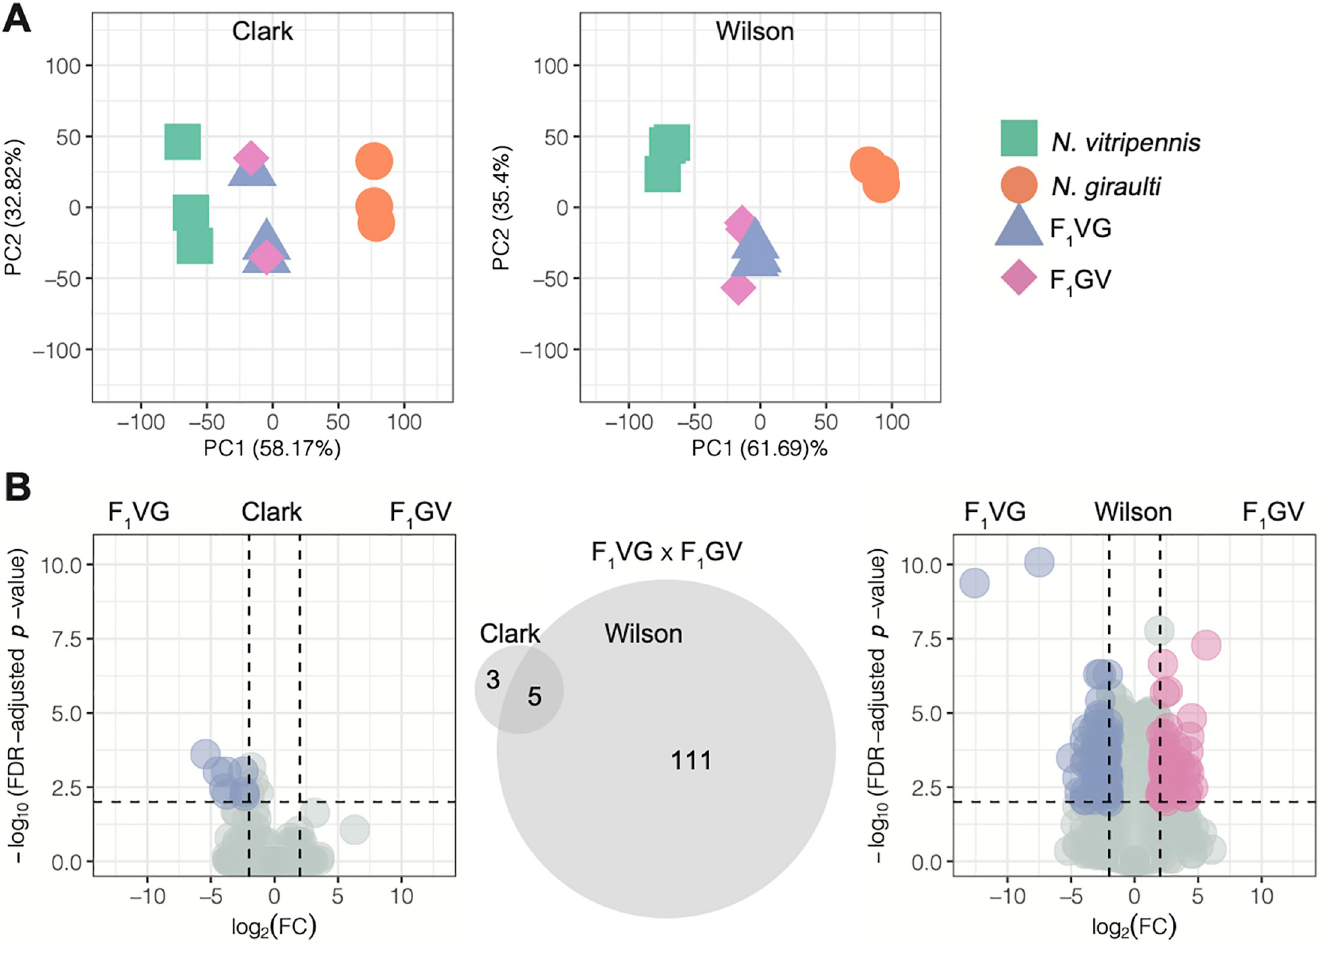
strain of N . giraulti , R16A, that has a nuclear genome derived from N . giraulti but maintains N . vitripennis mitochondria, therefore the R16A Clark hybrids all have the same genetic makeup whereas the Wilson reciprocal hybrids have the same nuclear genome but different cytoplasms; yet, we do see eight genes called as differentially expressed between the VG and GV hybrids in the R16A Clark data. Three of the eight genes in the R16A Clark data (LOC116416025, LOC116416106, LOC116417553) were only called as differentially expressed between the VG and GV hybrids in the R16A Clark dataset and weren’t called as differentially expressed in the Wilson dataset. The other five genes (LOC107981401, LOC100114950, LOC116415892, LOC103317241, LOC107981942) were called as differentially expressed between the VG and GV in both datasets. In the Wilson data, we called 116 DEGs, 111 of which are unique to the Wilson data set. The original Wang et al. 2016 publication did not investigate differential expression between the hybrids [20]. Here we report a new way of look- ing at the data, and despite the same genetic makeup between the hybrids in the R16A Clark data, we do observe differential expression between the hybrids, and five of those eight genes are also called as differentially expressed in the Wilson data.